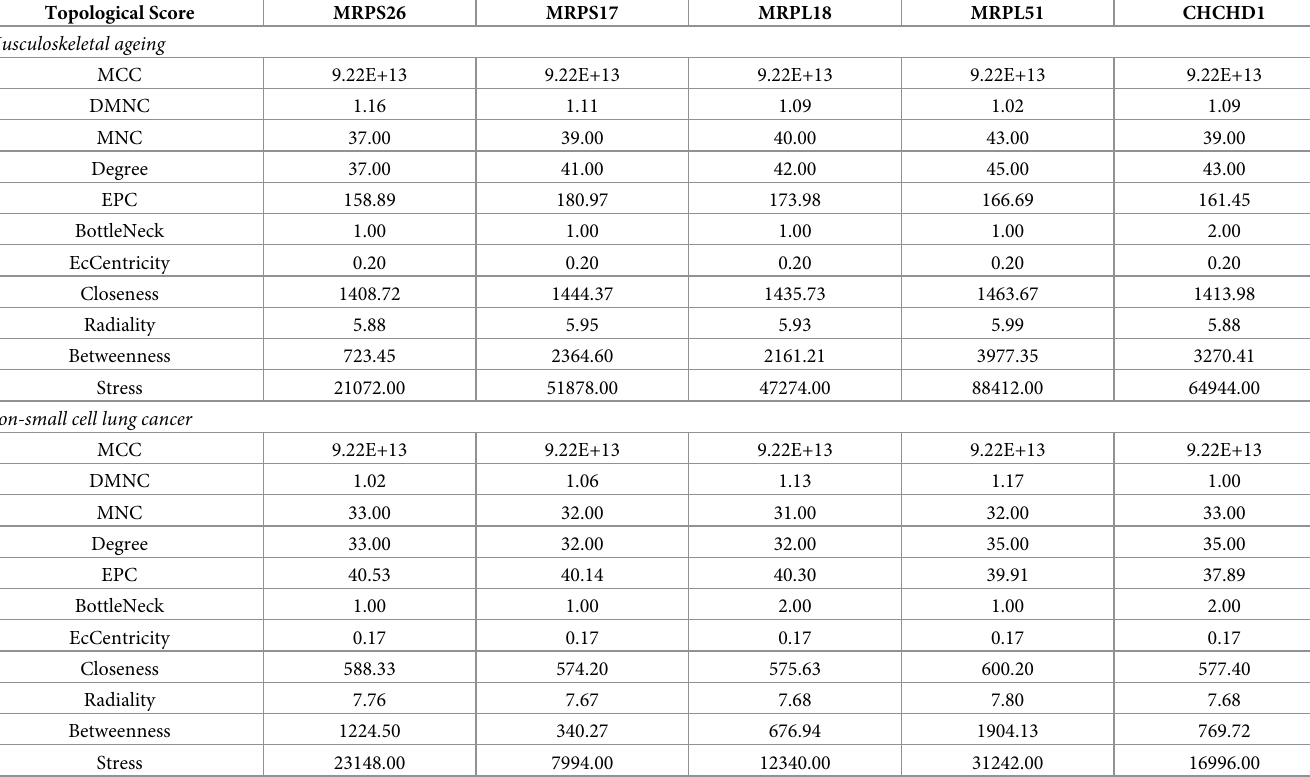
Table 3. Five highest-ranked hub genes according to 11 topological algorithms ranked in the protein-protein interaction network of differentially expressed genes between musculoskeletal ageing and non-small lung cancer. Numbers represent score. Topological Score MRPS26